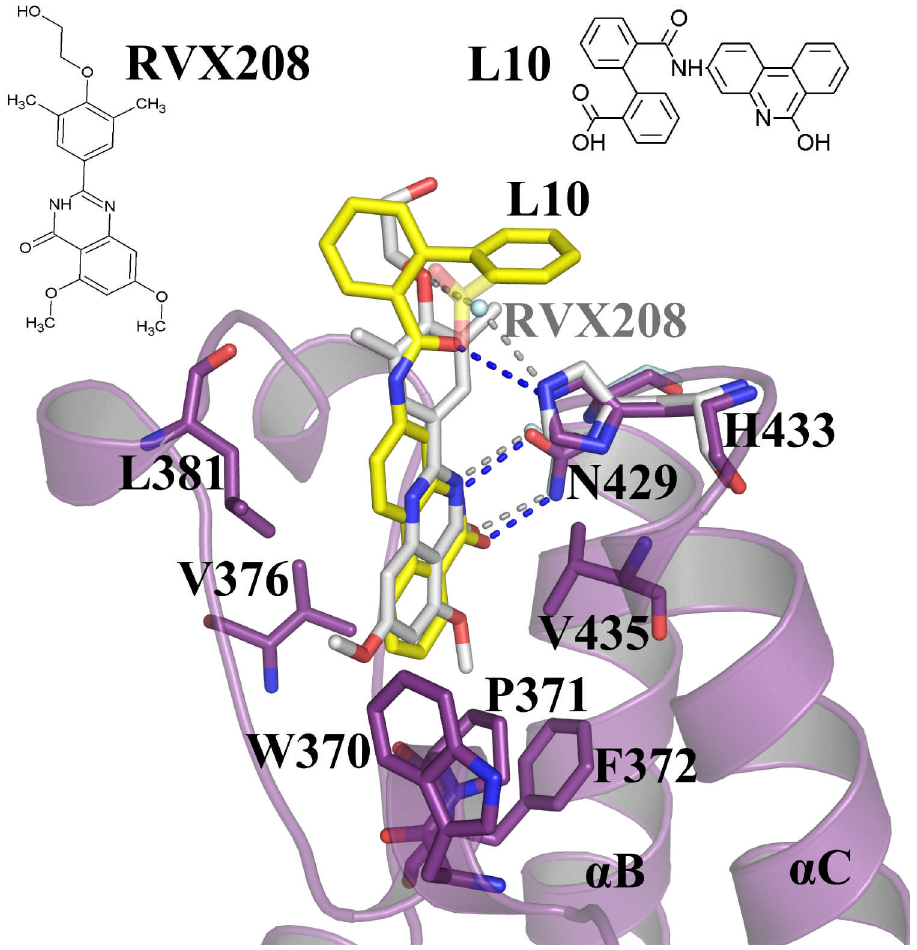
Fig 7. Superposition of the BD2-RVX-208 and BD2-L10 complexes. Hydrogen bonding interactions formed by L10 towards N429 and H433 are shown in blue, and by RVX-208 towards N429 and H433 are shown in grey. L10 is shown in yellow. RVX-208 is shown in grey. Residues corresponding to BD2-L10 and BD2-RVX-208 are shown in purple and grey, respectively. The ligands and the interacting residues are shown as sticks. The hydrogen bonds are shown as broken